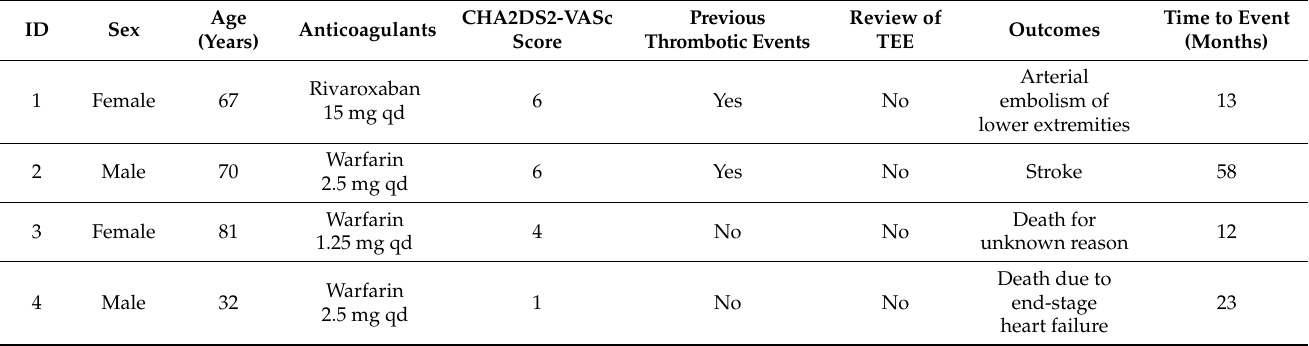
Table 4. Characteristics of patients who suffered thrombotic events or death during